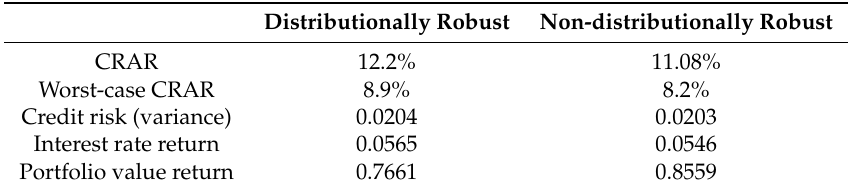
Table 6. Performance index of distributionally- and non-distributionally-robust models. CRAR, Capital to Risk Assets Ratio